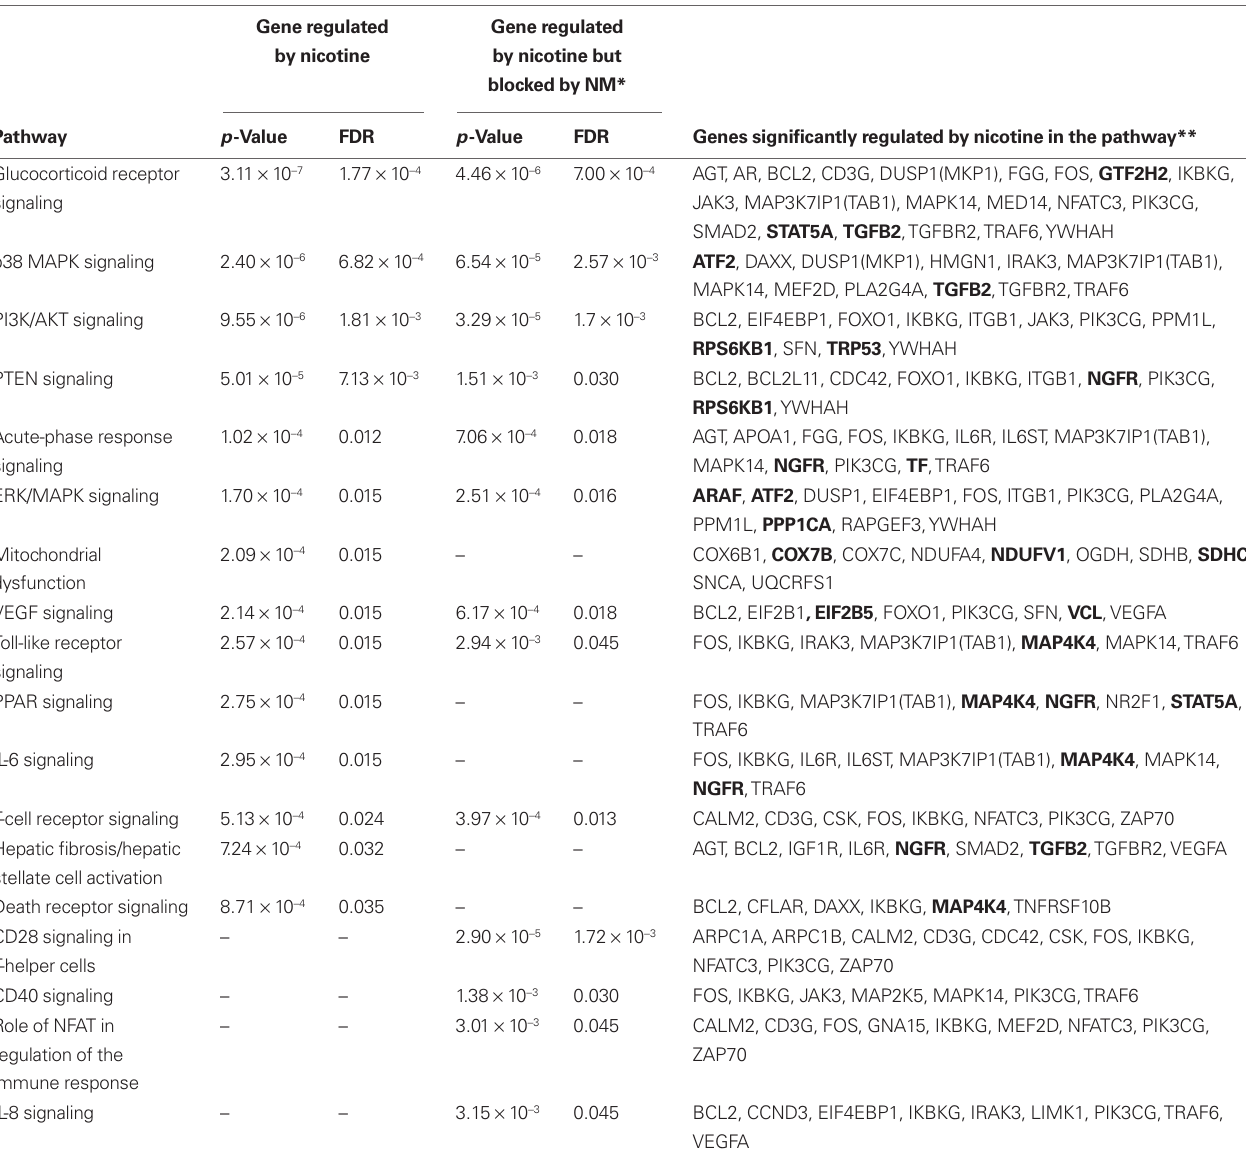
Table 1 | Pathways enriched in genes significantly regulated by nicotine and genes significantly regulated by nicotine but not by nicotine +